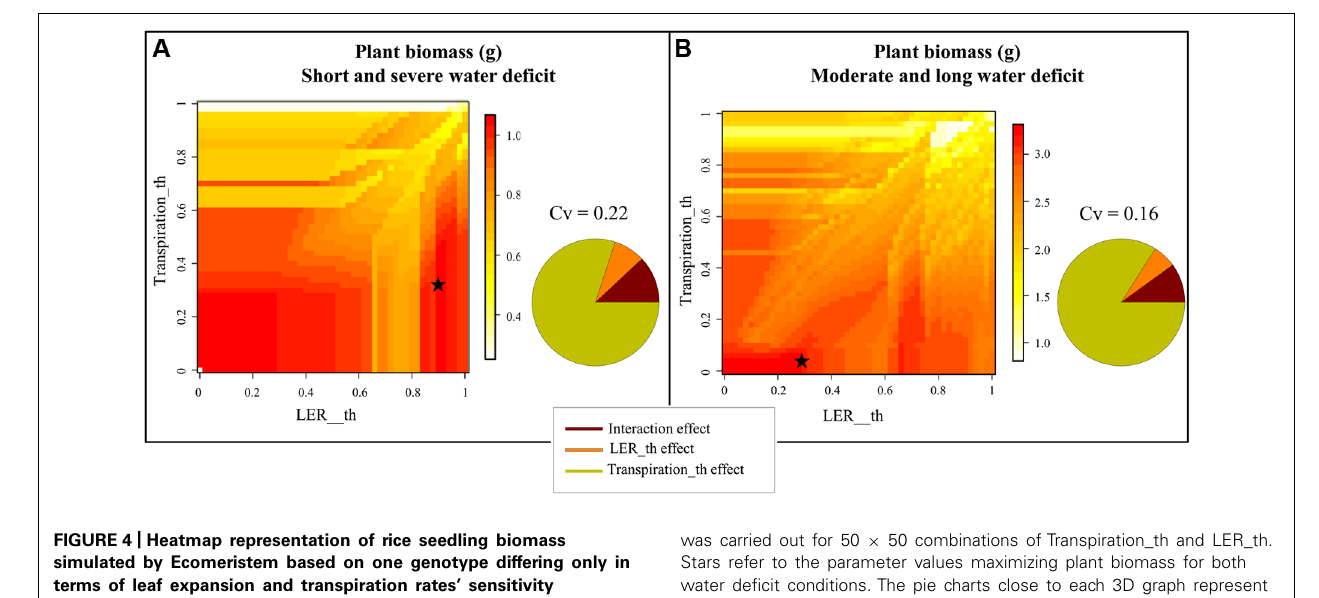
taken on leaf lamina of the leaf located two ranks below the last emerging leaf. See Figure 1 for further explanations on harvest dates. Significant differences between water stress or rewatering treatments and control were tested. Significance values: * P < 0.05; ** P < 0.01; *** P < 0.001; ns, not significant.